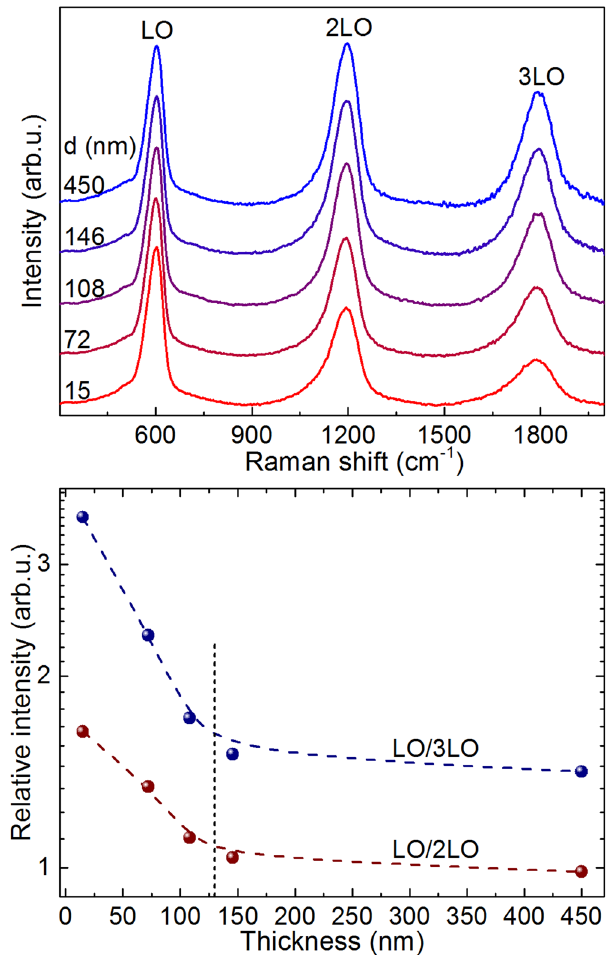
Figure 7. Top: Raman spectra (normalized to the intensity of the LO peak) from layers series (ii) with Mg/ (Mg + Zn) = 0.1 and different thickness. Bottom: Relative intensity of the first order LO peak in relation to that of the second order and third order peaks versus layer